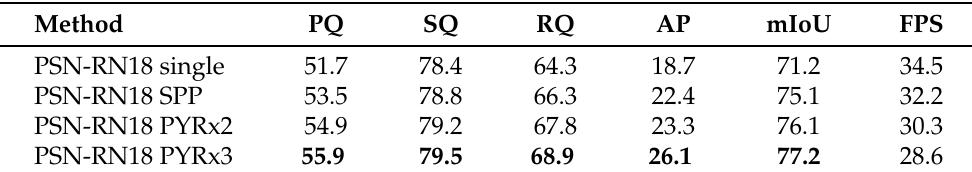
Table 6. Comparison of pyramidal fusion with spatial pyramid pooling [35] on Cityscapes val. Both PYRx1 and SPP models operate on single resolution and hence can not exploit pyramidal fusion. The SPP model applies spatial pyramid pooling to 32 × subsampled abstract features at the far end of the backbone [45].